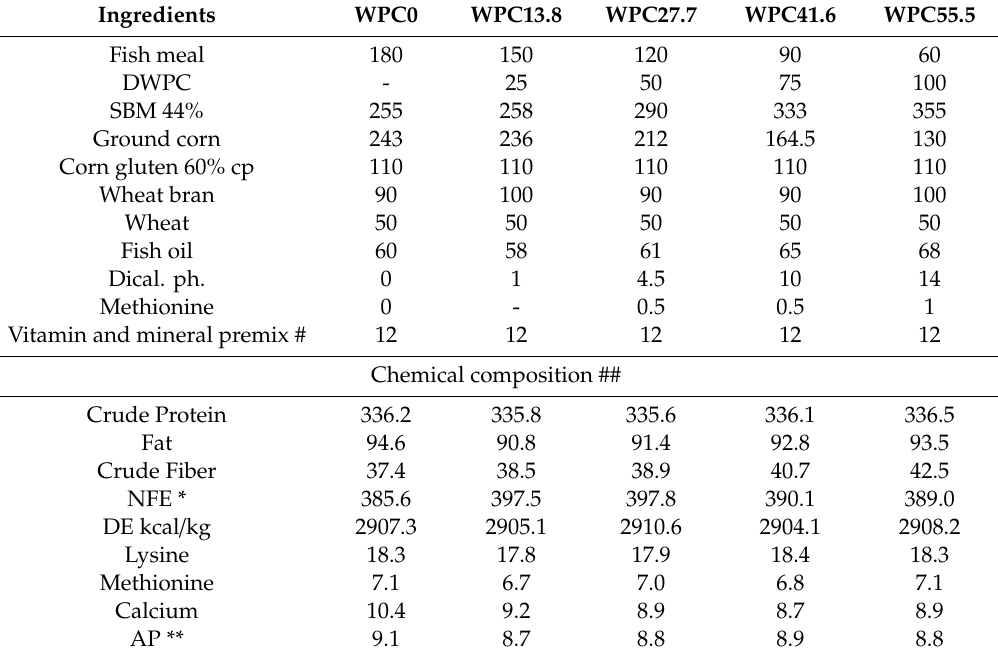
Table 1. Proximate chemical composition of the experimental diets (g / kg).